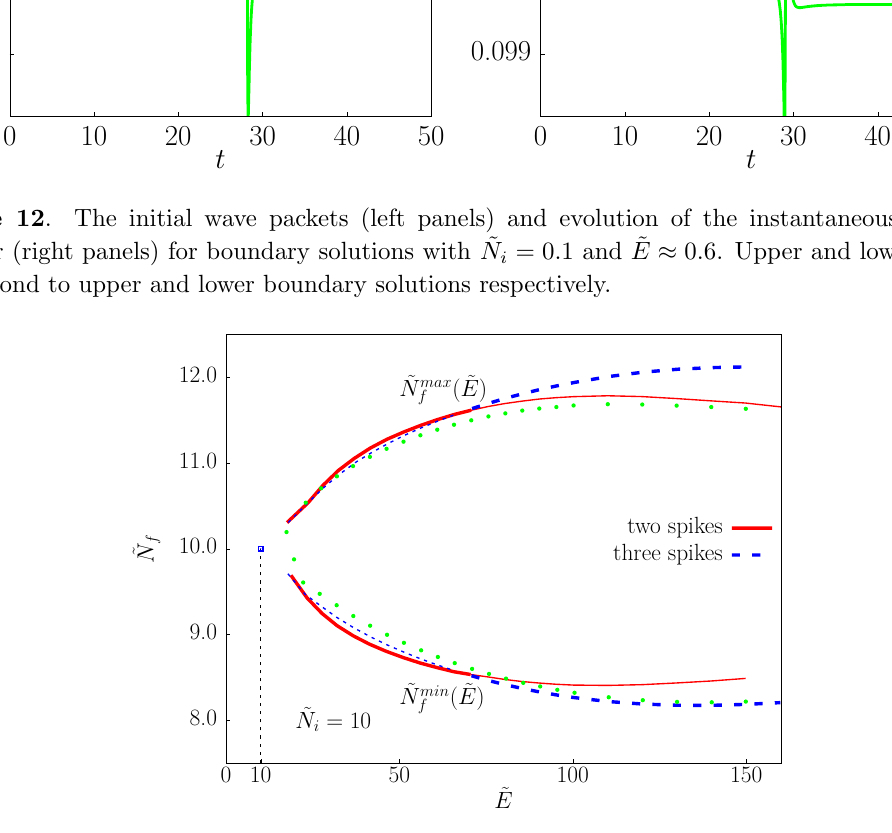
Figure 13 . The classically allowed region in ( ~ E; ~ N f ) plane for ~ N i = 10 : 0; N r = 600 ; R = 30. The envelopes ~ N min and ~ N max are composed of the classical solutions with two spiky parts (thick red f f line) and with three spiky parts (dashed blue line). The dots show other branches of the solutions which deliver some local minima to F (or ~ N f